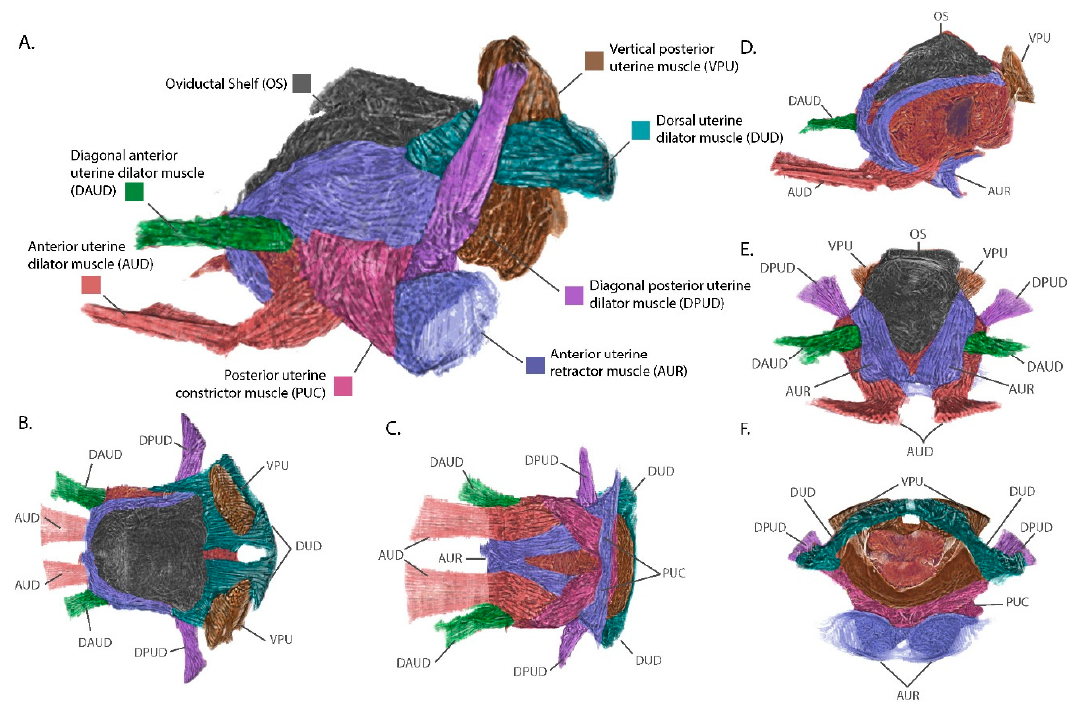
Figure 2. Views of the uterus and associated connective tissues with annotated musculature groups. ( A ) Lateral view; ( B ) Dorsal view; ( C ) Ventral view; ( D ) Orthogonal view with sagittal section. ( E ) Anterior view. ( F ) Posterior view. Muscular group colorations and acronyms are defined in the figure legend.